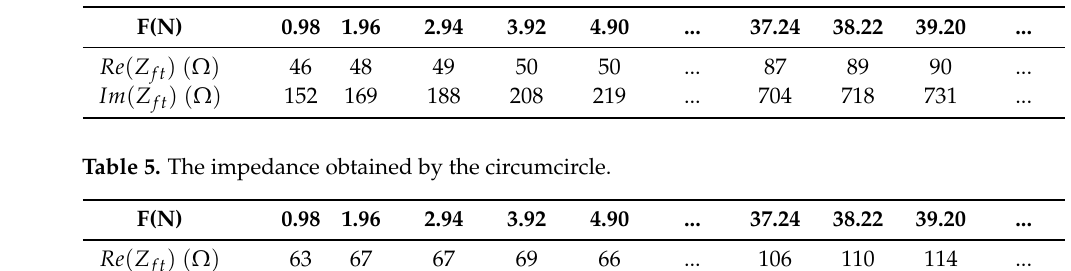
Table 4. The impedance obtained by the inscribed circle.